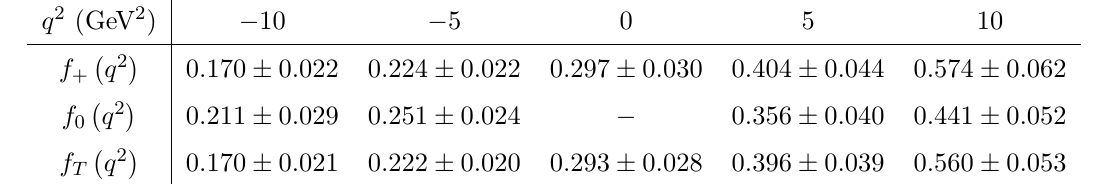
Table 2 . LCSR inputs at various values of q 2 and the respective correlations are taken from ref. [22].